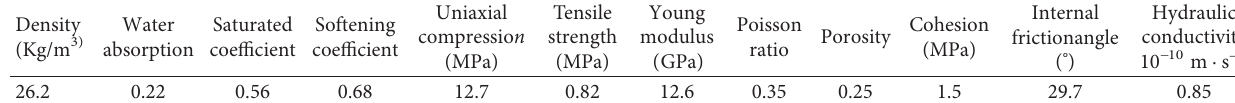
Table 1: The rock mass calculation parameters of the Maokou limestone.